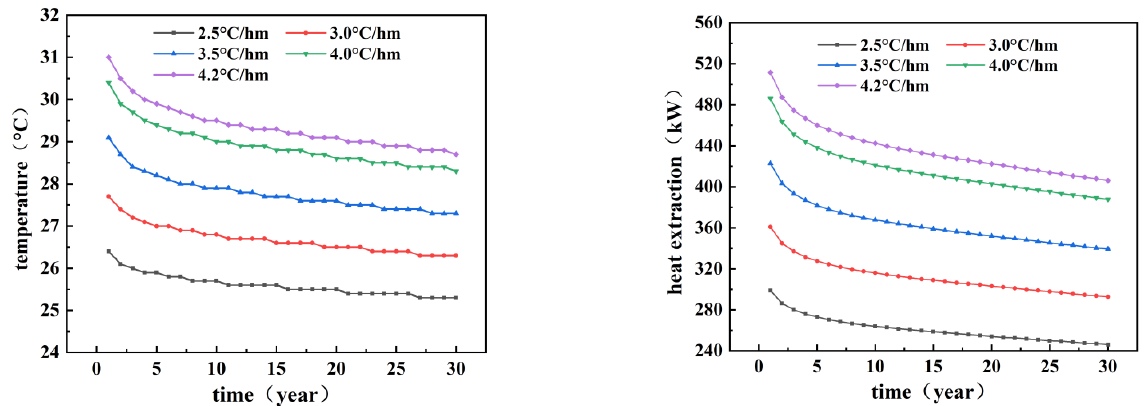
Figure 8. Optimized production temperature and heat extraction for M1 well at different geothermal gradients.